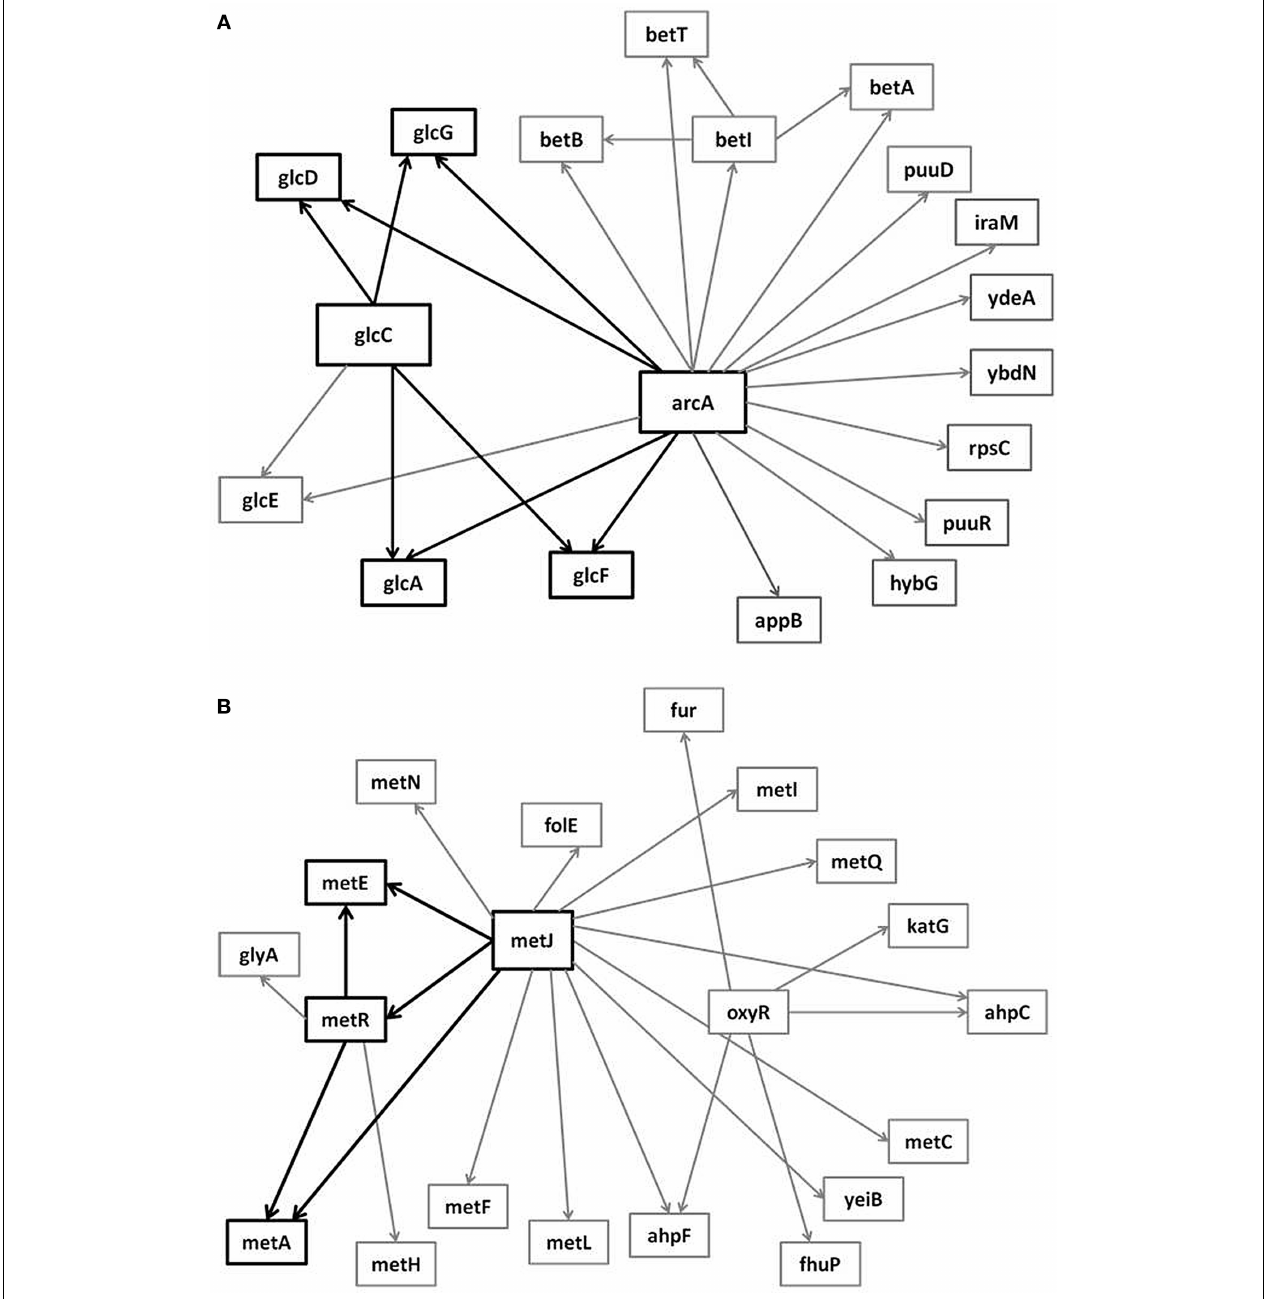
FIGURE 1 | Embedded within sample GRN subgraphs of E. coli , the topological representation of (A) bifans . Here, transcription factors arcA and glcC co-regulate glcD and glcG. On the other hand, (B) the feed-forward loop constitutes a transcription factor (such as metJ) that regulates both a gene (metE) and another transcription factor (metR). The regulated transcription factor co-regulates the same gene (metR ! metE).